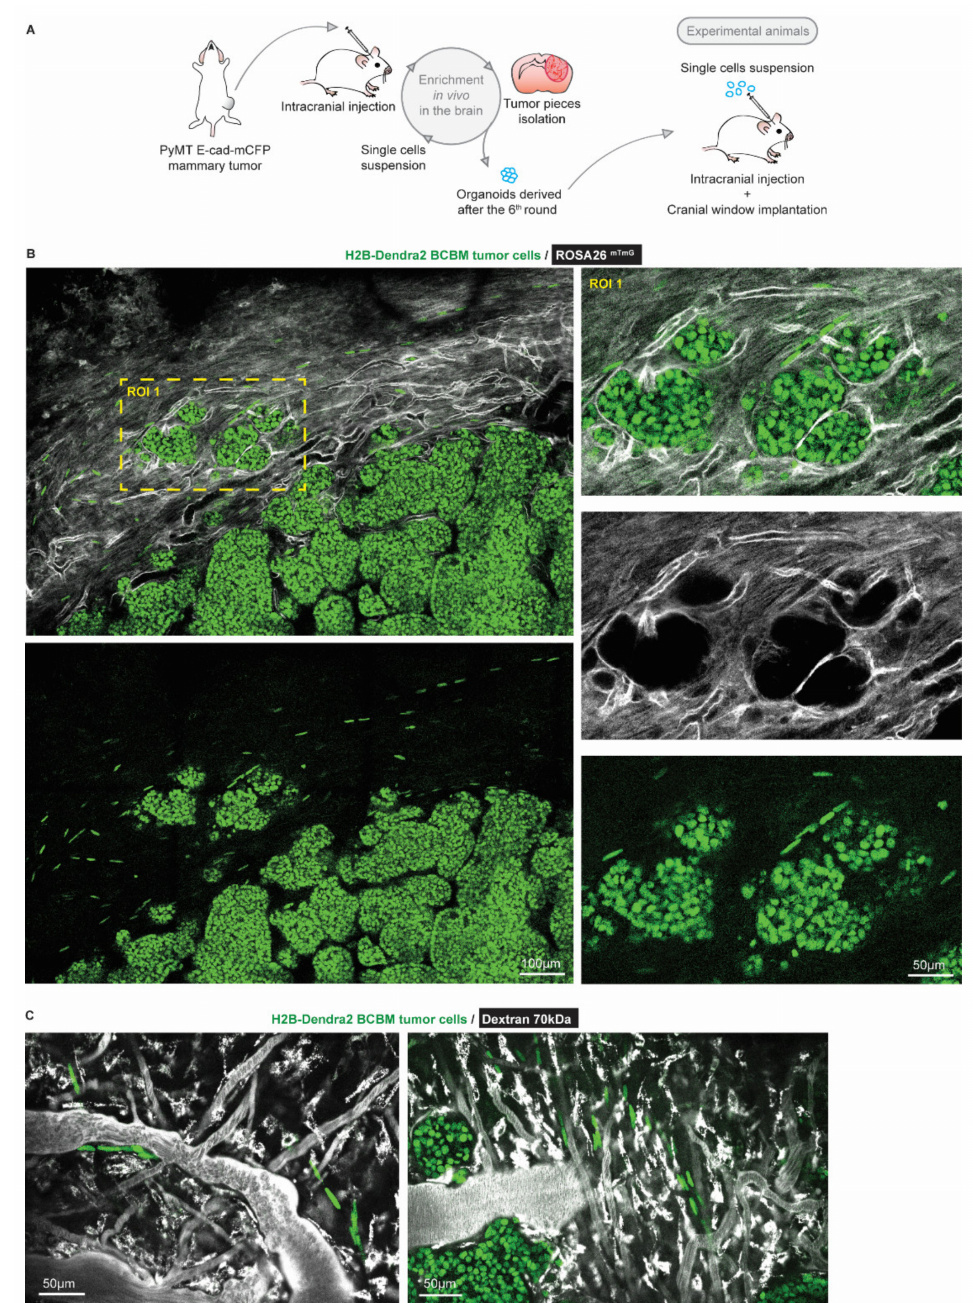
Figure 1. Intravital microscopy reveals the presence of single tumor cells at the invasive front of BCBM. ( A ) Schematic representation of the generation of a BCBM model derived from PyMT, E-cad- mCFP tumor. ( B ) Representative image ( n = 4 mice) obtained by multi-photon imaging through a cranial window of a BCBM invasive front, 2 weeks after tumor implantation. The image depicts tumor cells expressing H2B-Dendra2 (green) grown in ROSA26 mTmG mice. The mouse brain parenchyma expressed tdTomato (mTmG; grey). The invasion front shows the presence of single tumor cells expressing H2B-Dendra2 (green) that are disconnected from the tumor lobules and associated with the brain vasculature (mTmG, grey). ( C ) Representative pictures obtained by multi-photon imaging through a cranial window of BCBM 2 weeks after tumor implantation. Images show single tumor cells expressing H2B-Dendra2 (green) in close association with blood vessels. Blood vessels were imaged with 70 kDa fluorescent-dextran